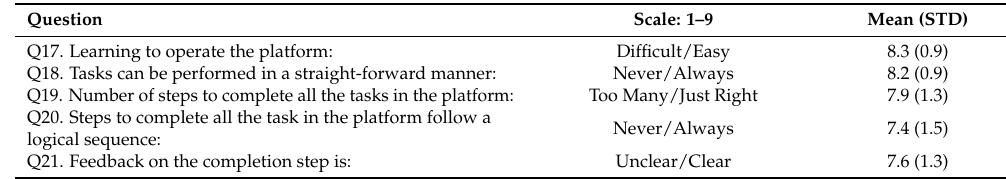
Table 7. Results of QUIS Part 4—Learning.